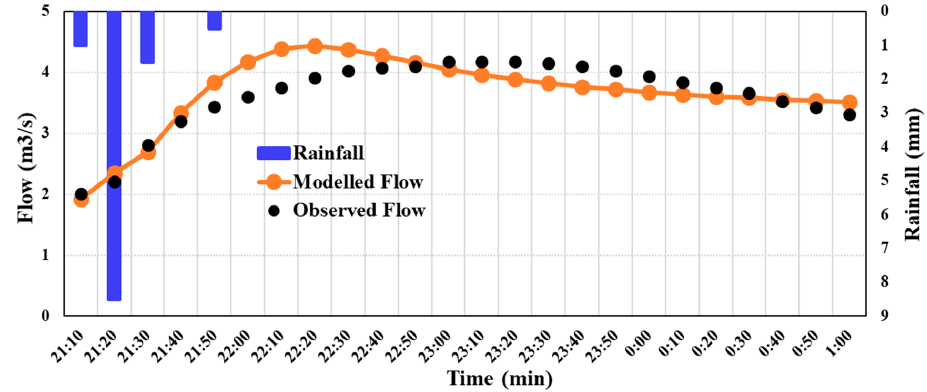
Figure 6. Validation of the model for the rainfall on 1 August 2017 event.